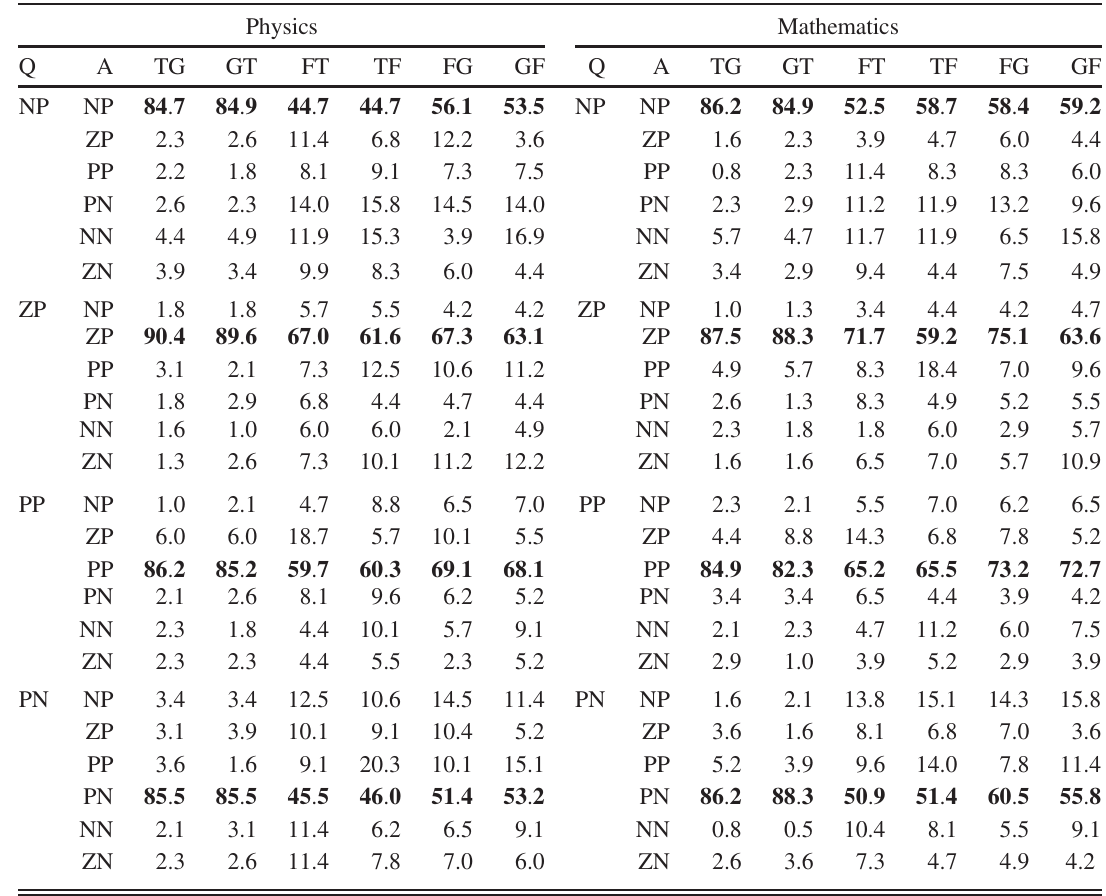
TABLE IV. Frequency (in percentages) of the chosen function type in the answer (A) as function of the function type and the representational transition in the question (Q) from all 385 respondents for all questions with a physics context (left) and with a mathematics context (right). Correct answers are in bold